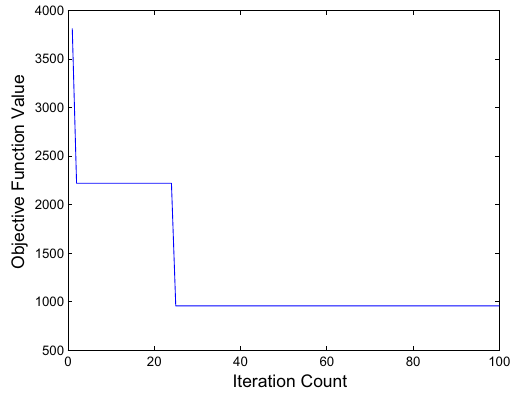
Fig. 3 Fitness function optimization over 100 iterations